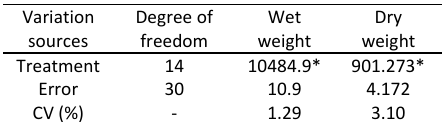
Table 7: ANOVA of the dill yield (wet/dry weight) Table 7. ANOVA of the dill yield (wet/dry weight) under various under various treatments treatments Variation Degree of Wet Dry sources freedom weight weight Treatment 14